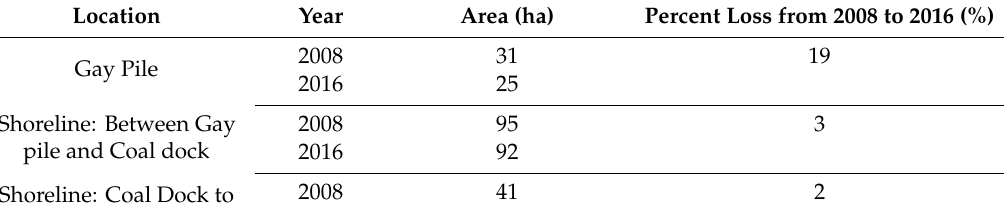
Table 2. Area and percentage of beach stamp sand lost, 2008 to 2016 (LiDAR).